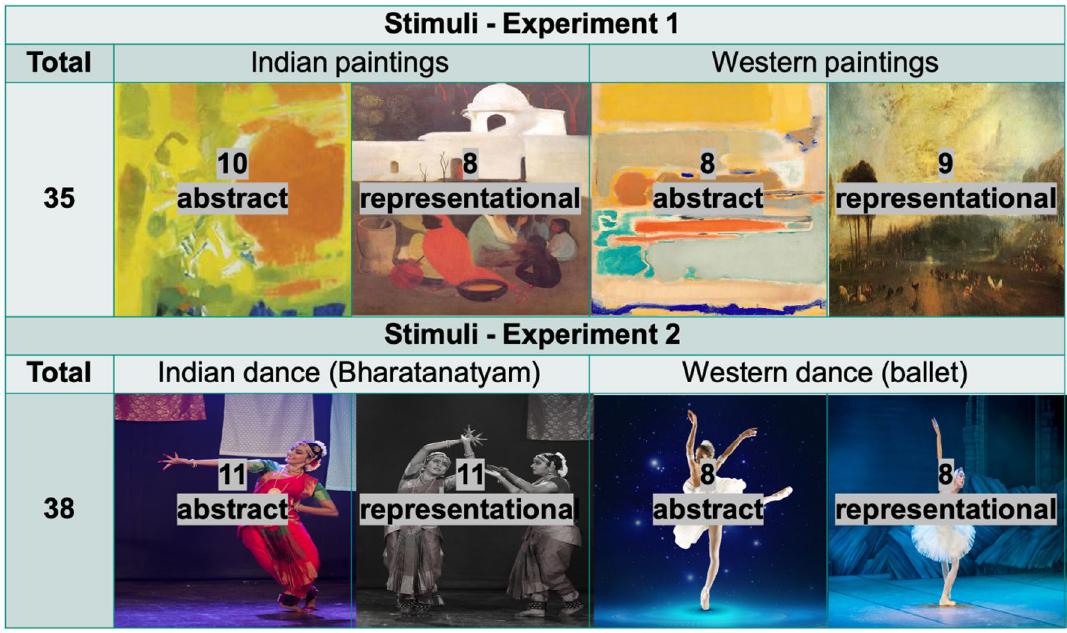
Figure 1. Categories of paintings and dance (abstract/representational) across different sources of painting or dance style (Indian/Western). Note: All images used in Figs. 1 and 2 are in the public domain, and/or we have informed consent from individuals for publication of their image in an online open access publication. Images used to depict abstract and representational paintings and dance in Figure 1 are not images of the actual stimuli used. Stimuli used in the current study are available online on the